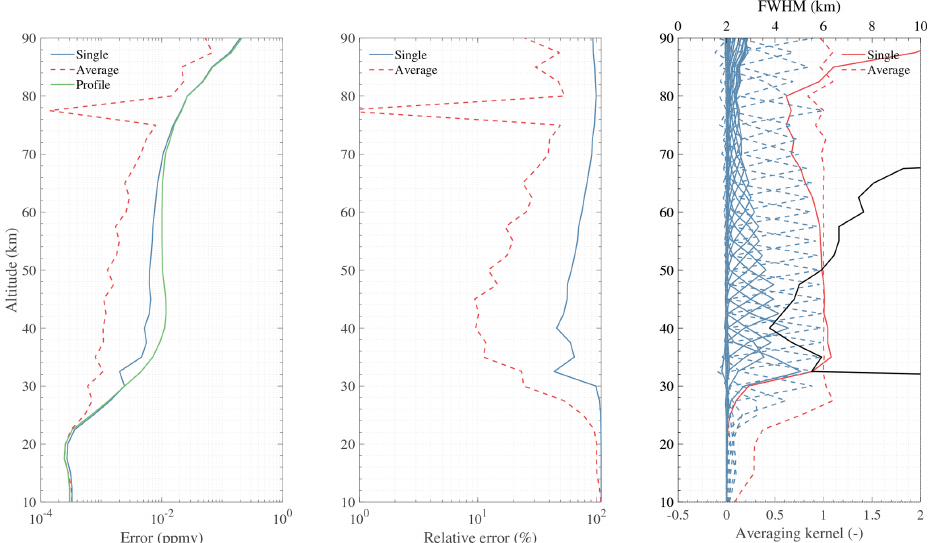
Figure 25. Simulation result of NO retrieval using 651.75GHz lines. “Single” and “Average” represent the retrieval error using different noise. “Profile” represents the typical profile used in the simulation. The black solid line in the last panel represents the FWHM (i.e. vertical